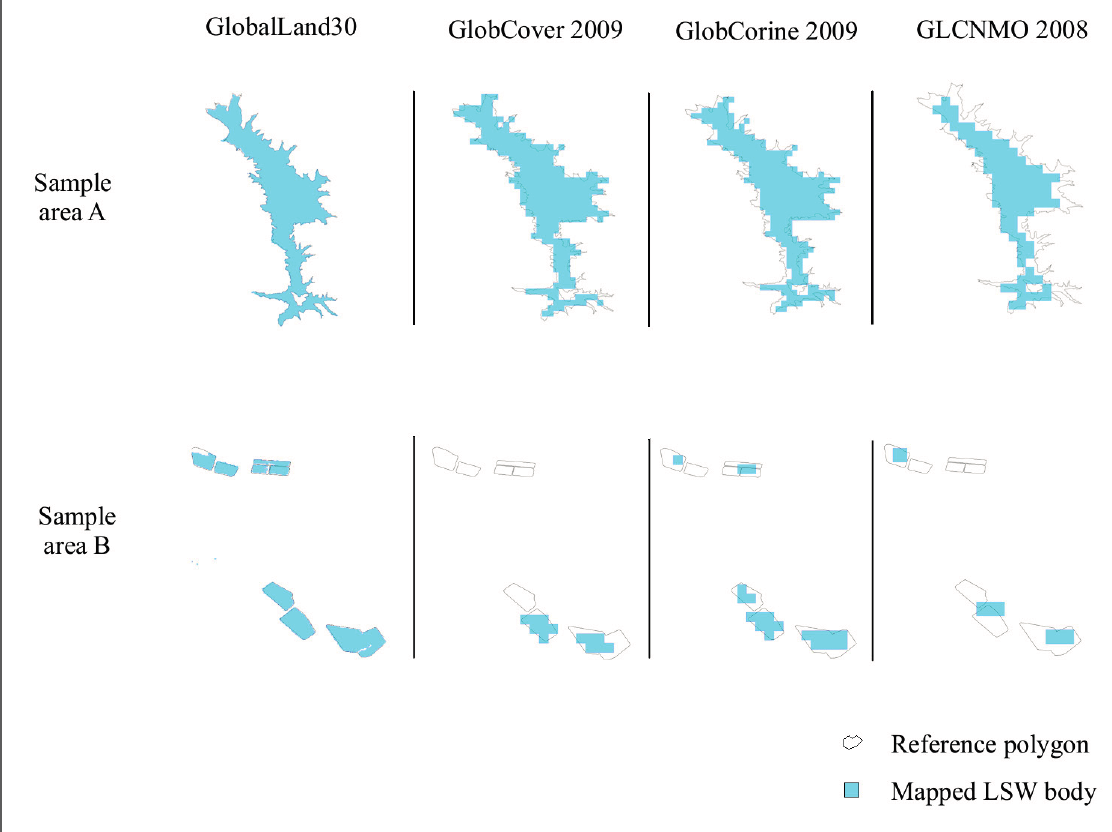
Figure 2. Registration performance visualization between the reference and the GlobalLand30, GlobCover 2009, GlobCorine 2009, and GLCNMO 2008 LSW layers, for two representative sample areas.